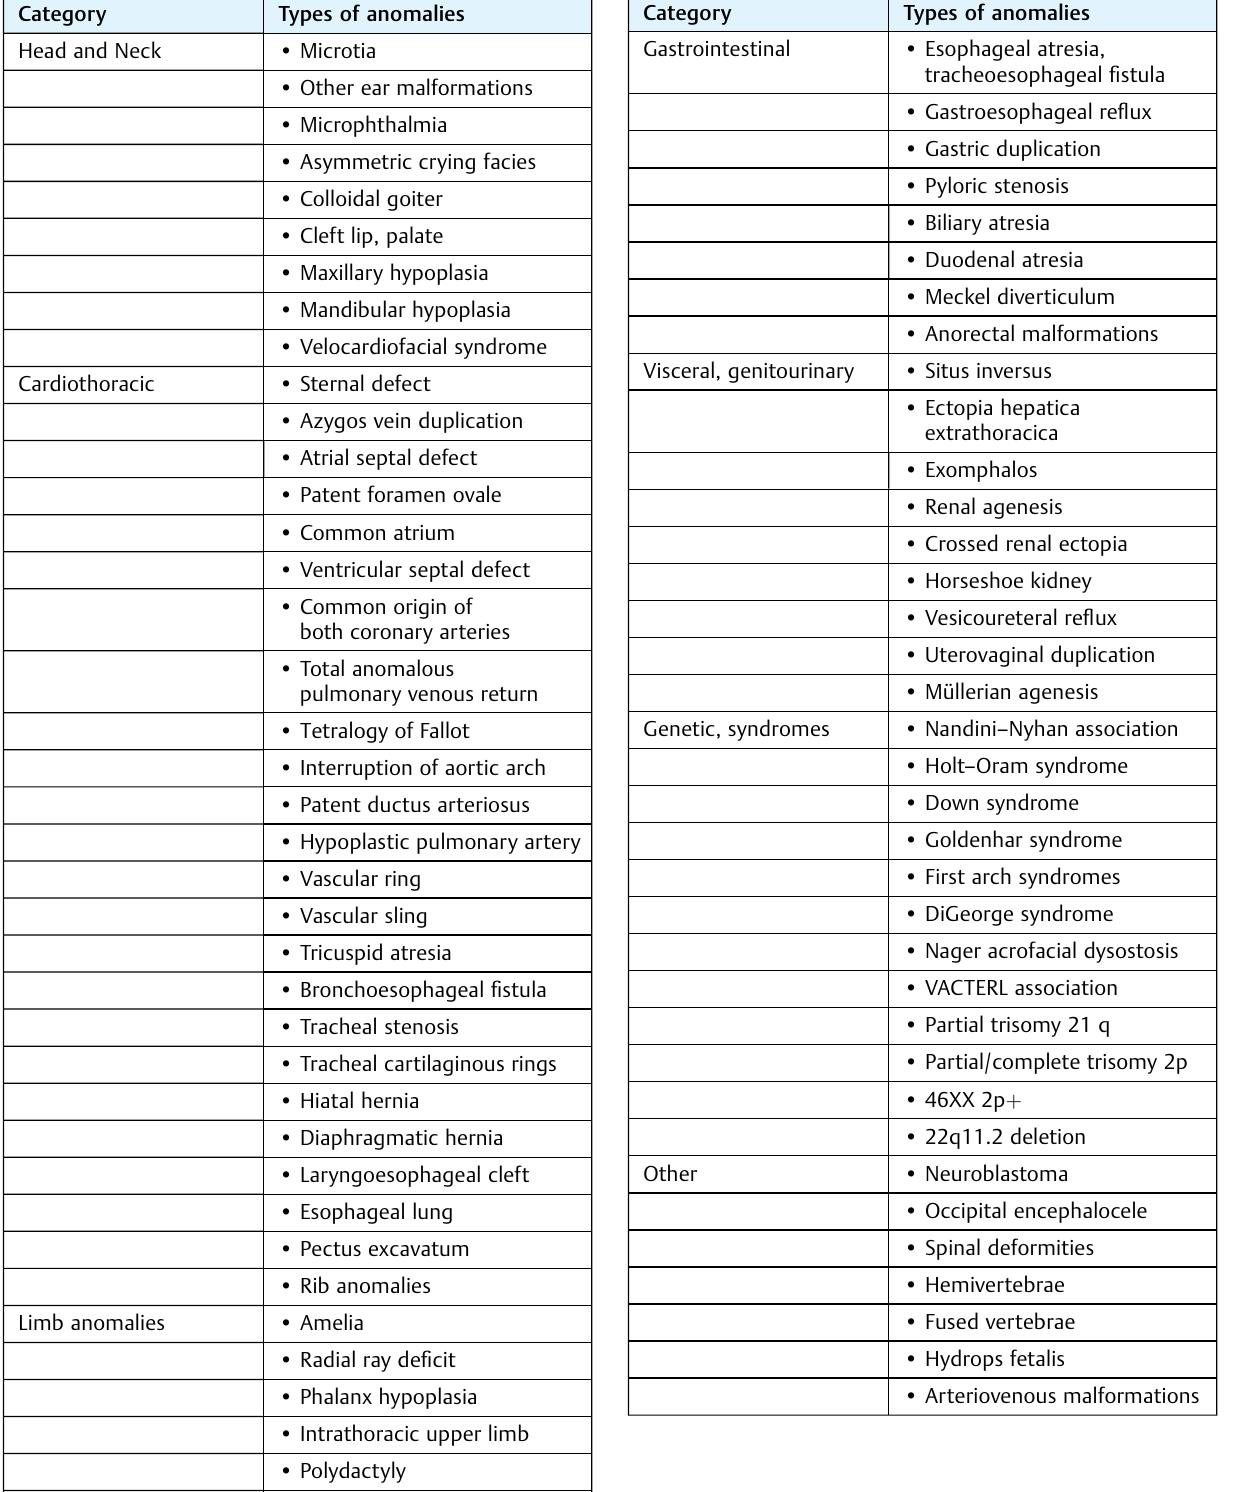
Table 1 Associated anomalies published in patients with pulmonary